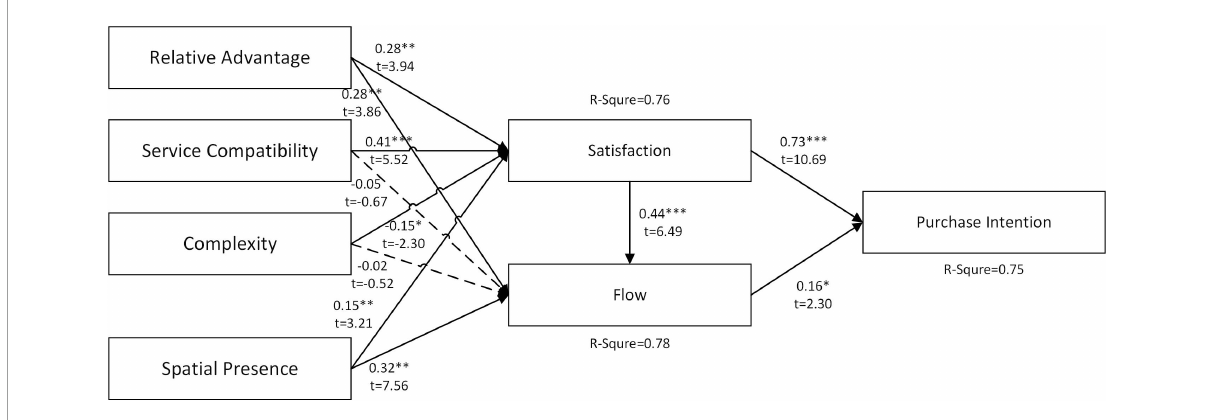
FIGURE2 Results of the full sample. *** P < 0.001, ** P < 0.01, * P < 0.05, ns – not